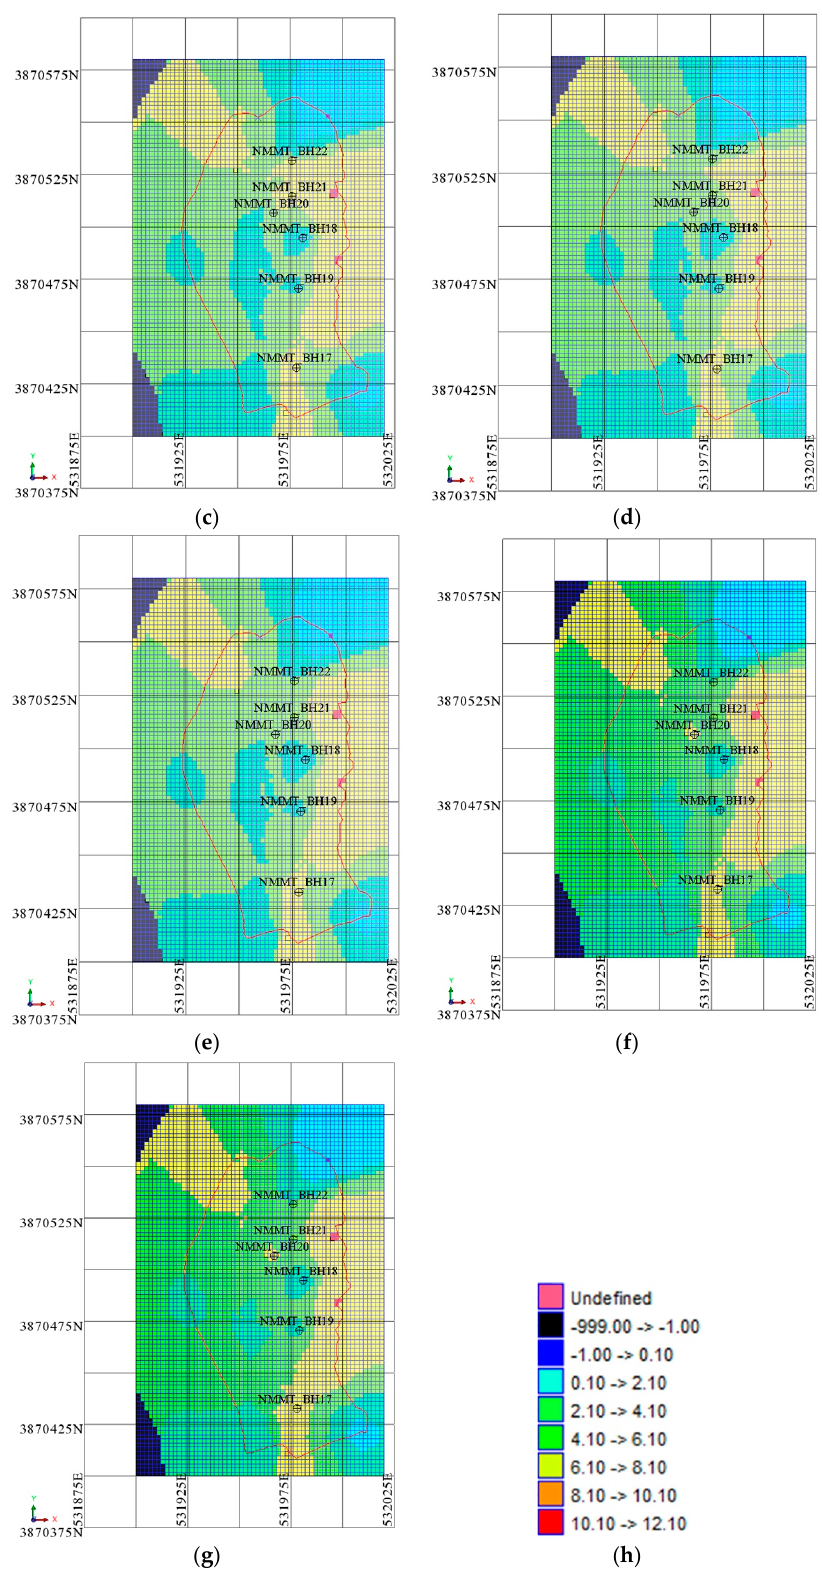
Figure 10. BM plans presenting the elevation (transformed) distribution as data from drillholes are imported into the Kriging algorithm when ( a ) no drillholes are used, ( b ) NMMT_BH18 is added to ( a , c ) NMMT_BH19 is added to ( b , d ) NMMT_BH21 is added to ( c , e ) NMMT_BH22 is added to ( d , f ) NMMT_BH20 is added to ( e , g ) NMMT_BH17 is added to ( f , h ) colormap